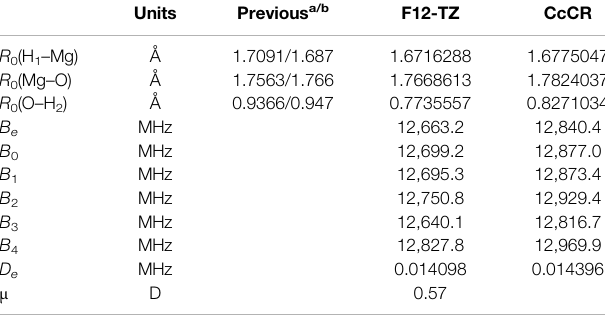
TABLE 4 | Geometry and spectroscopic constants of HMgOH.